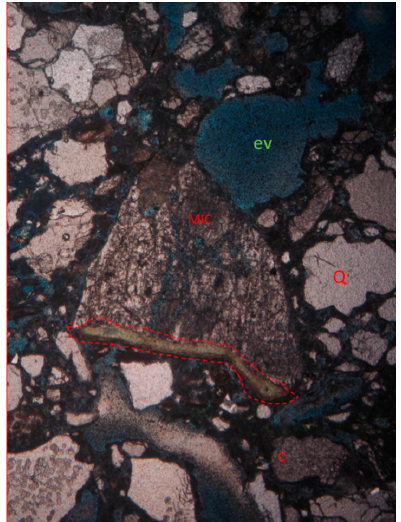
Figure 8. Micrograph of sample S-005 (2.5×). Q: quartz; C: calcite; mic: microcline (K-feldspar); ev: